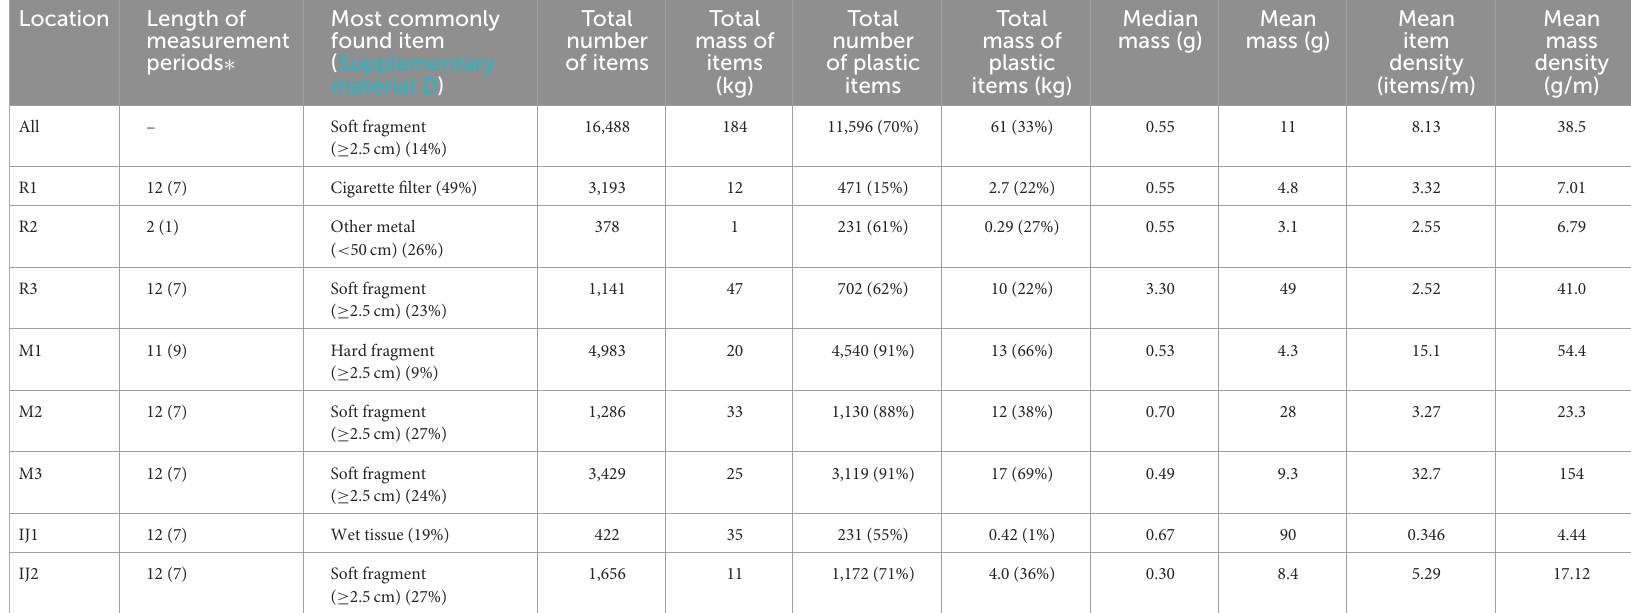
TABLE 1 Statistics of all the collected